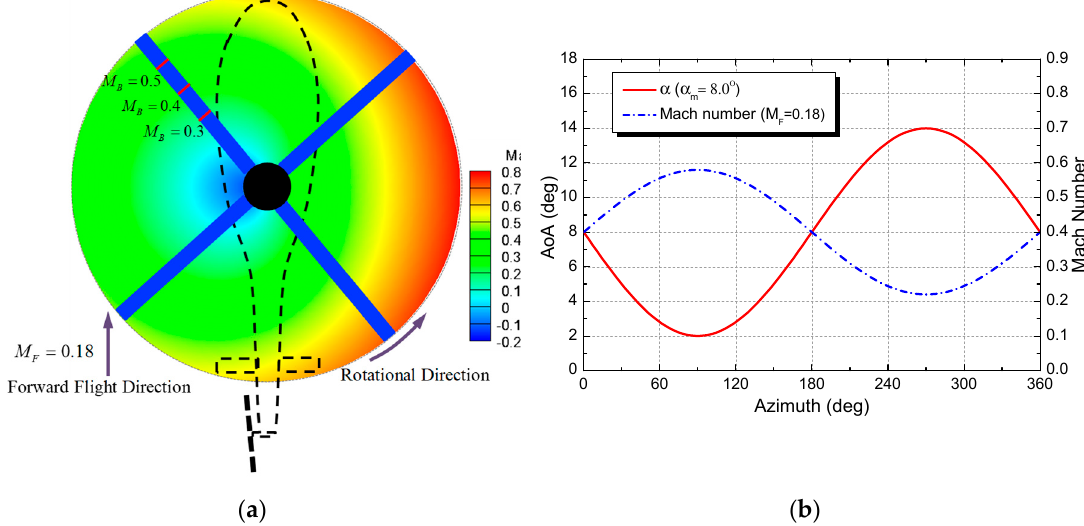
Figure 1. Mach number distribution of rotor disk and angle of attack (AoA) variation with rotor azimuth. ( a ) Mach number distribution. ( b ) AoA and freestream velocity variations.